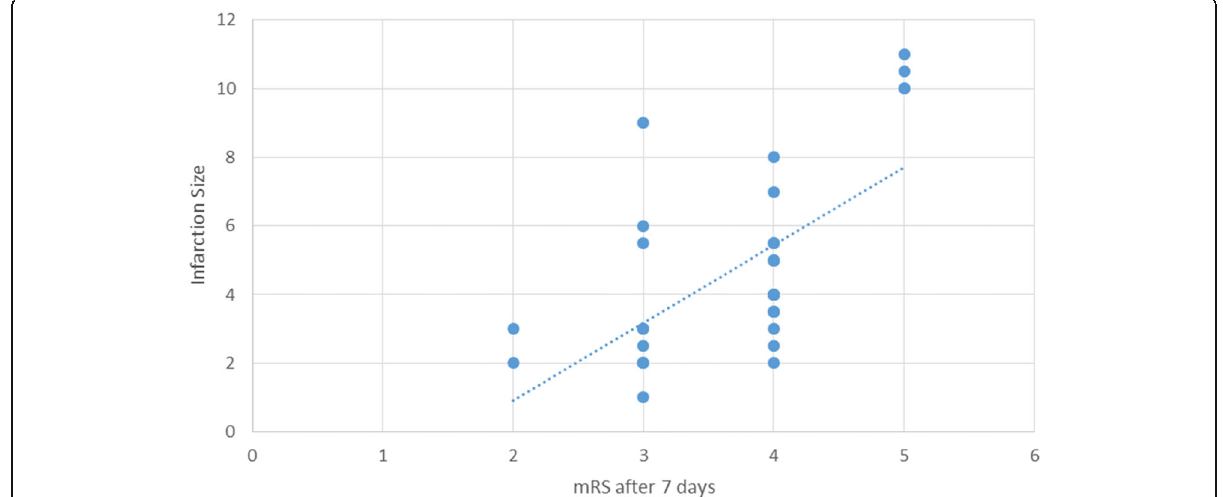
Fig. 3 Correlation between modified Rankin scale (mRS) after 7 days and infarction